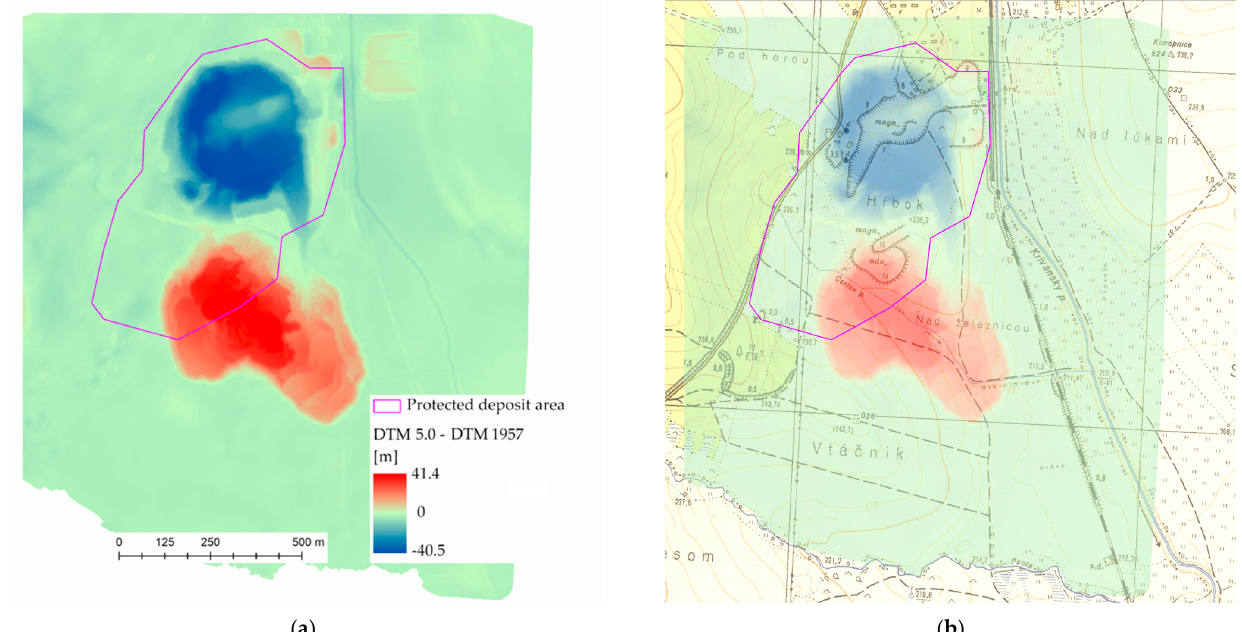
Figure 8. Elevation changes in the deposit area: ( a ) comparison of DTMs for the years 1957 and 2019; ( b ) topographic map from 1957 (Source: https://geoportal.gov.sk/sk/map?b=19.6012652,48.406453, accessed on 23 September 2021).